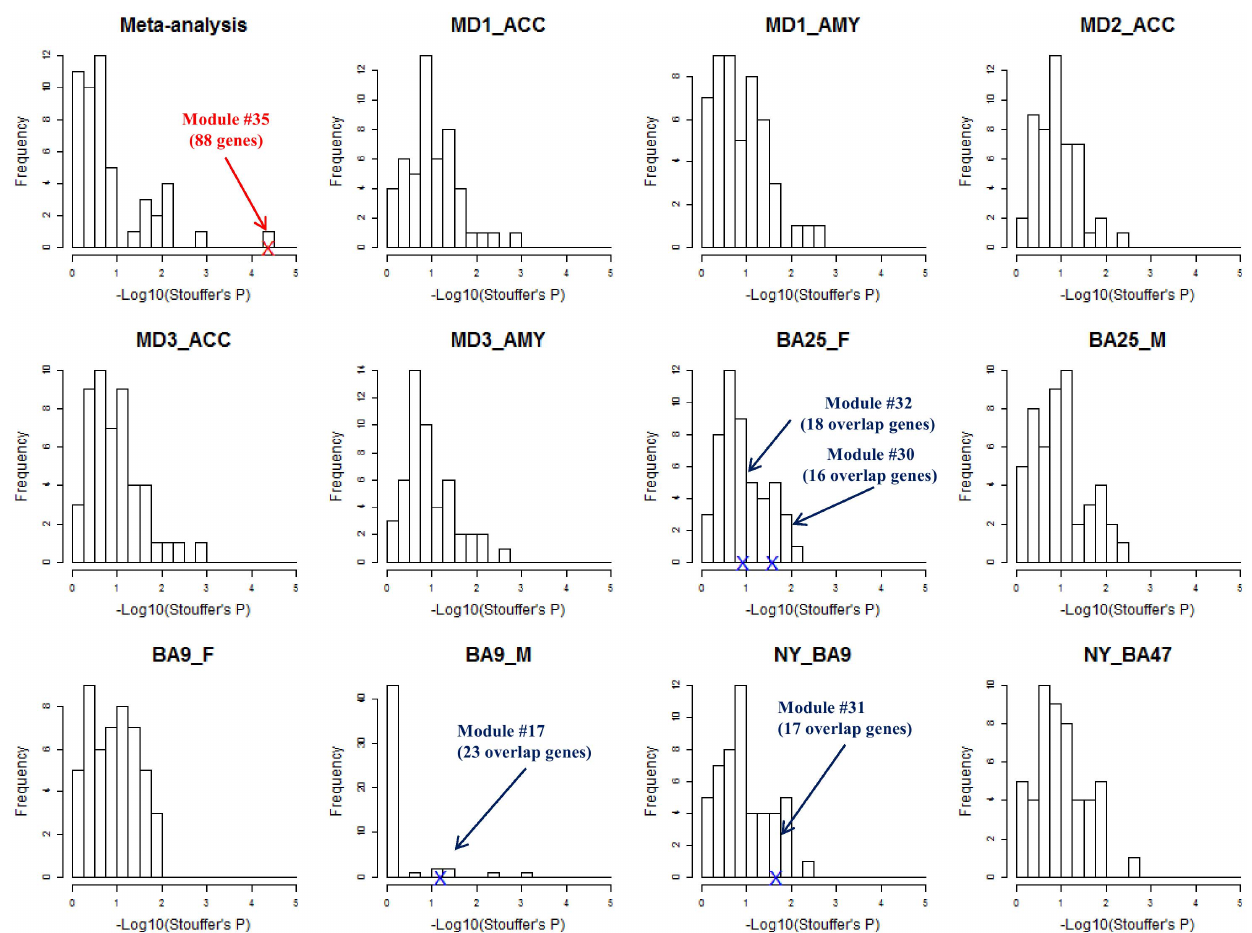
Figure 3. Histograms of the –log 10 (p) of the Stouffer statistic from 50 modules of meta-analysis of 11 MDD studies and each single study. Module # 35 with 88 genes (red arrow and double-cross) have largest –log 10 transformed p-value of Stouffer’s statistic 4.4. The other four blue arrows and double crosses indicated that these four modules in all single studies have more than 14 (15% of the 88 genes in module # 35) overlapped with module # 35. See detailed description in